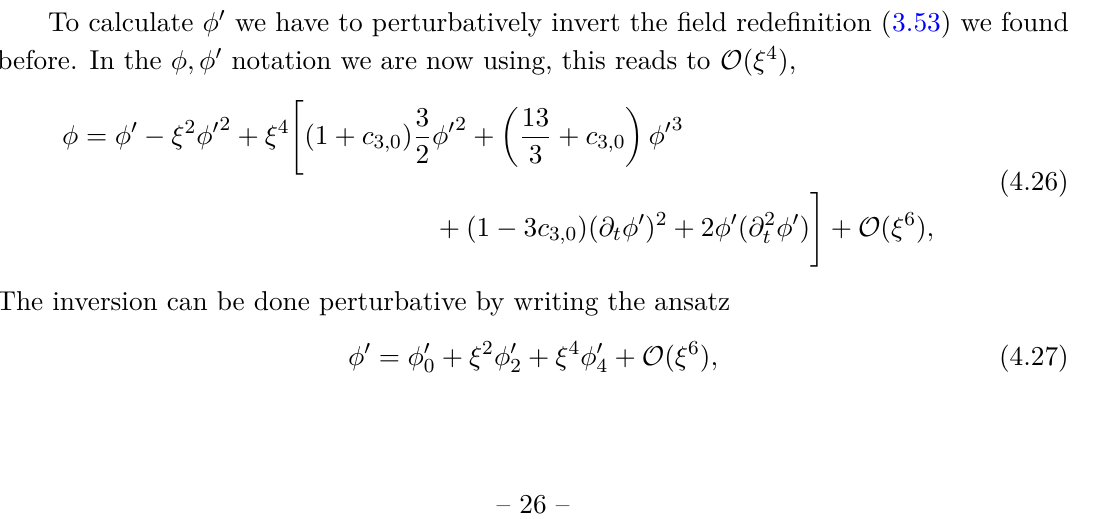
up to n ≤ 14 . The turning point at n